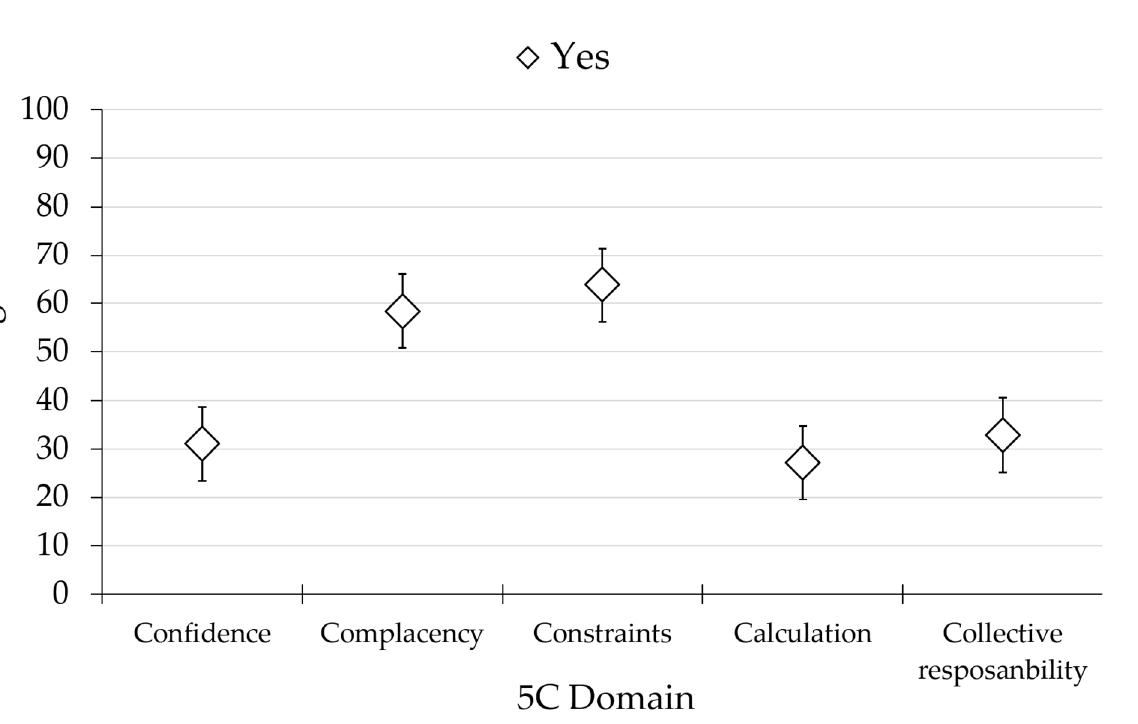
Figure 1. The 5C psychological antecedents of monkeypox vaccination in the study sample. Acceptance of each psychological domain is represented as an error bar.